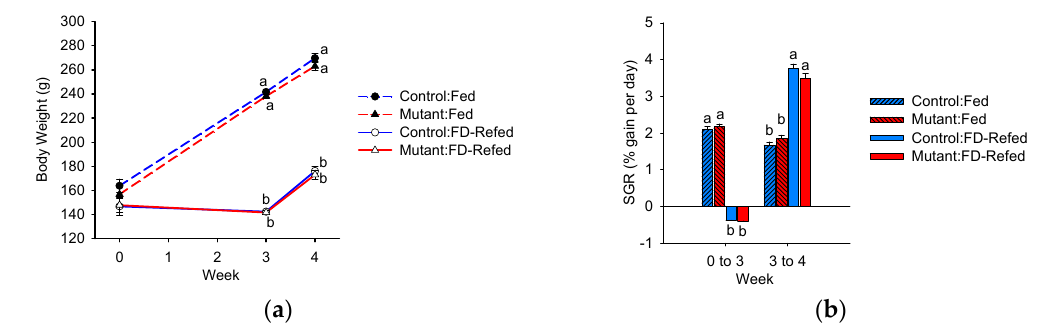
Figure 2. Body weight ( a ) and specific growth rate (SGR) ( b ) over the course of the trial. Differences between treatment groups within the same experimental week are indicated by different letters ( p < 0.05, n = 21 or 42). FD: feed deprivation.